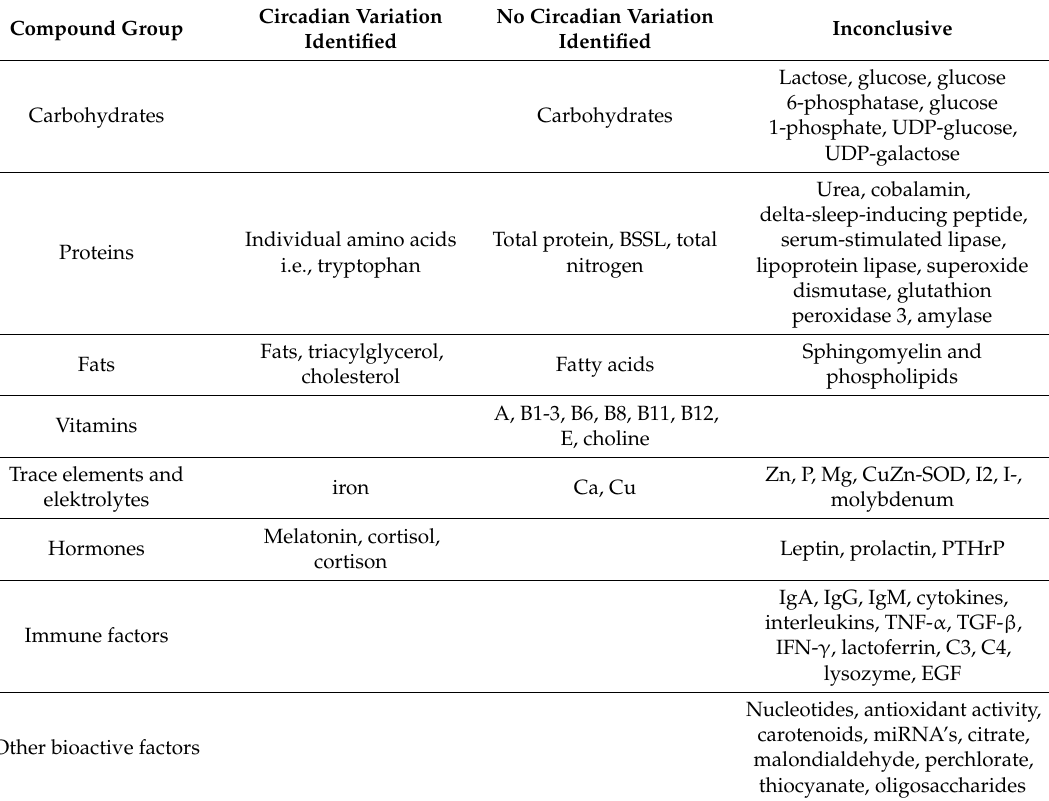
Table 1. Summary of evidence on circadian variation in human milk components, showing conclusions per compound